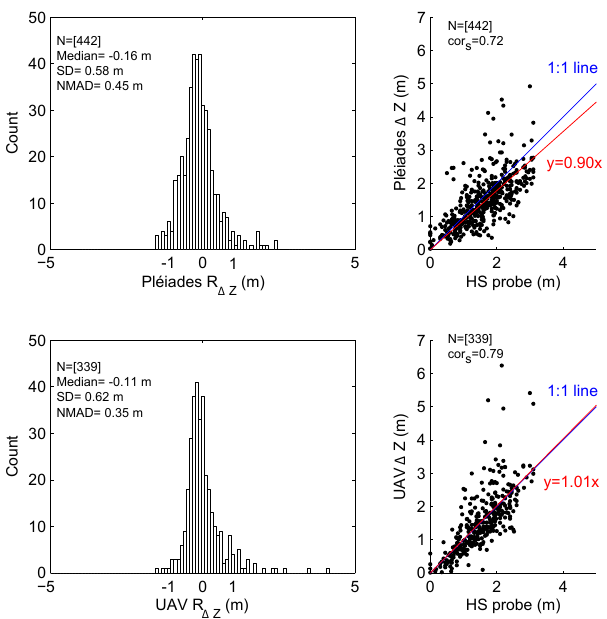
Figure 7. Top left: histogram of the distribution of the residu- als between the 2m Pléiades dDEM and the snow-probe measure- ments. Bottom left: histogram of the distribution of the residuals be- tween the 2m UAV dDEM and the snow-probe measurements. Top right: scatter plot between the 2m Pléiades dDEM and the snow- probe measurements. Bottom left: scatter plot between the 2m UAV dDEM and the snow-probe measurements. Blue line is the 1:1 line. Red line is the least-square best fit of a linear function with a zero intercept y = a x